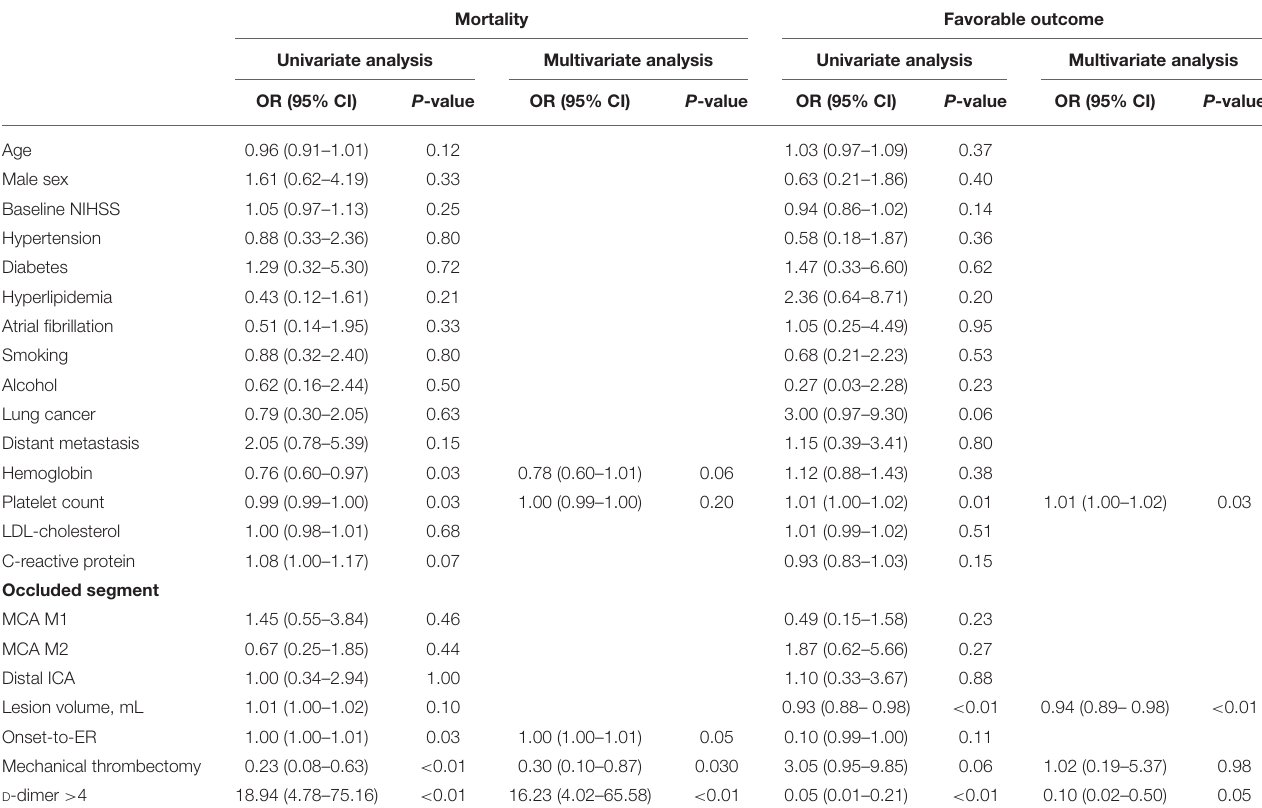
TABLE 3 | Regression analysis of mortality and favorable outcomes. Mortality Favorable outcome Univariate analysis Multivariate analysis Univariate